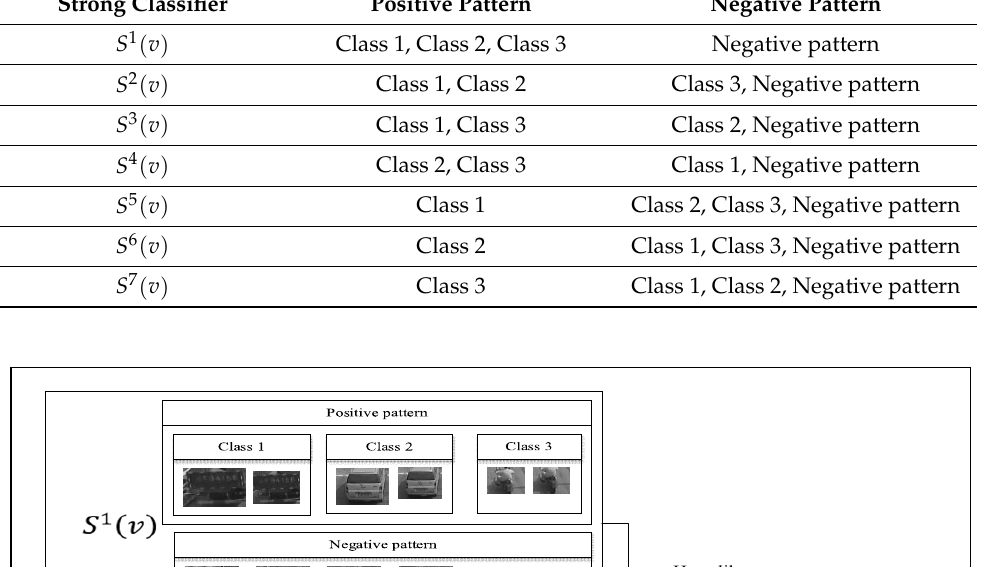
Table 2. Training data of each classifier.